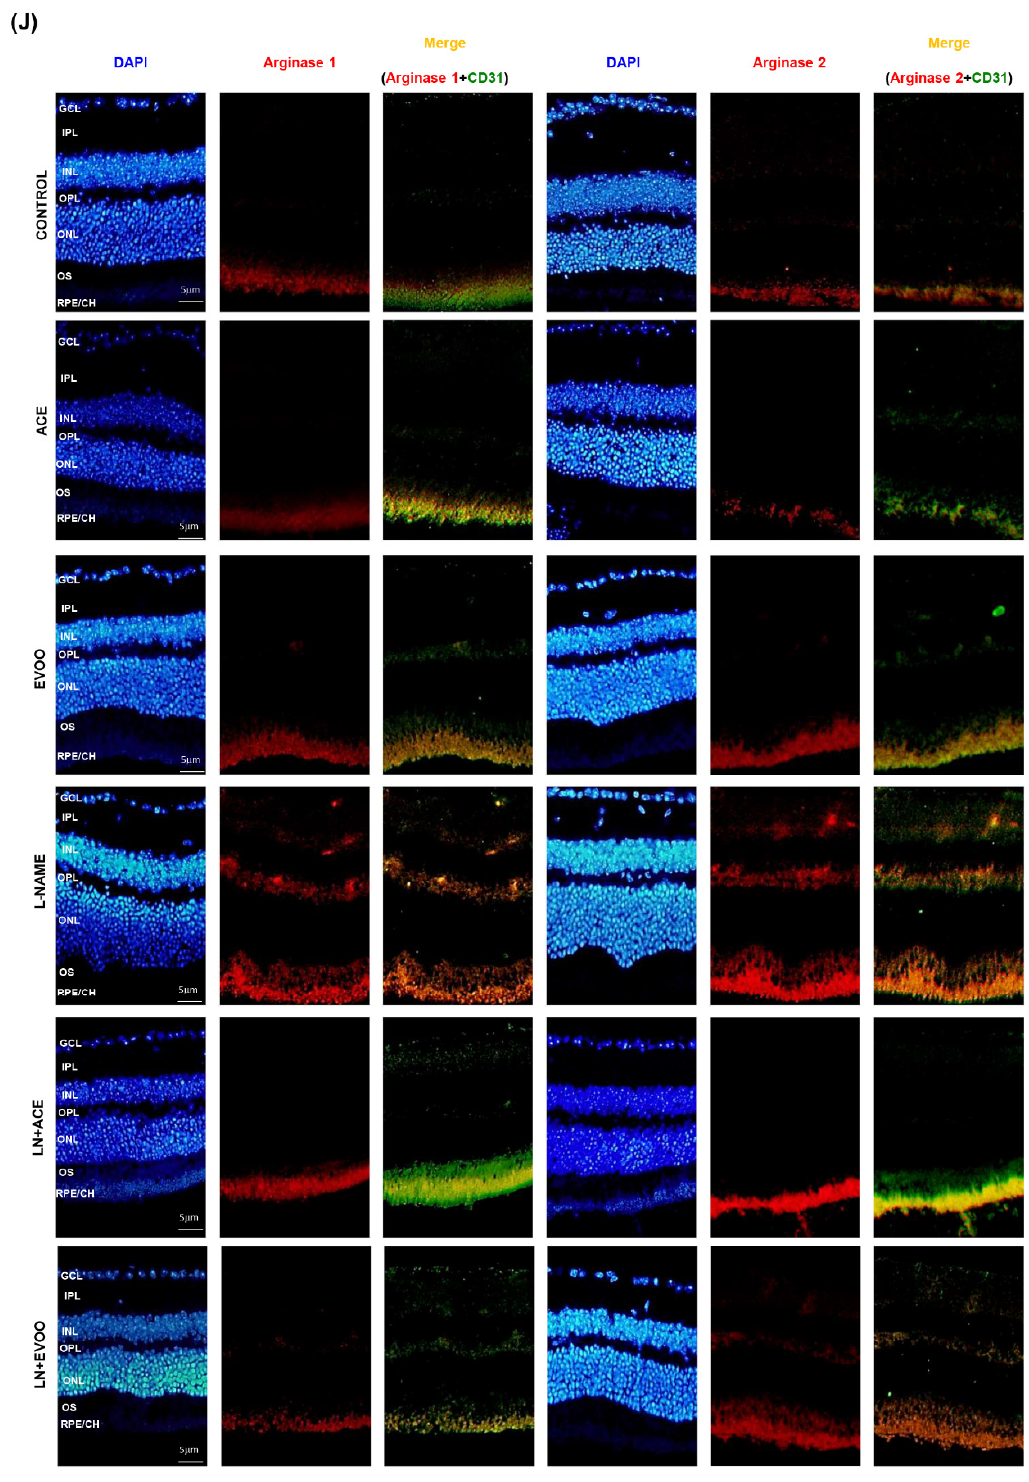
Figure 6. Total eNOS (T-eNOS) mRNA expression ( A ) and protein expression ( B ) in retina homogenates from all experimental groups. The activation status of eNOS enzyme was estimated from the ratios: ( C ) p-eNOS Ser 1177 / T-eNOS (activation); ( D ) p-eNOS Thr 495 / T-eNOS (inhibition); and ( E ) p-eNOS Ser 1177 / p-eNOS Thr 495 . ( F ) mRNA and protein expression of iNOS isoform in retina homogenates. ( G ) NO concentration in retina homogenates. ( H , I ) Protein expression of arginase isoforms 1 and 2 in retina homogenates. ( J ) Arginase 1 (left) and arginase 2 (right) expression (red color) and double staining with CD-31 (green color) in retinal layers, where the merge is represented in yellow color. Nuclei staining with DAPI (blue color) was used to identify retinal layer in each